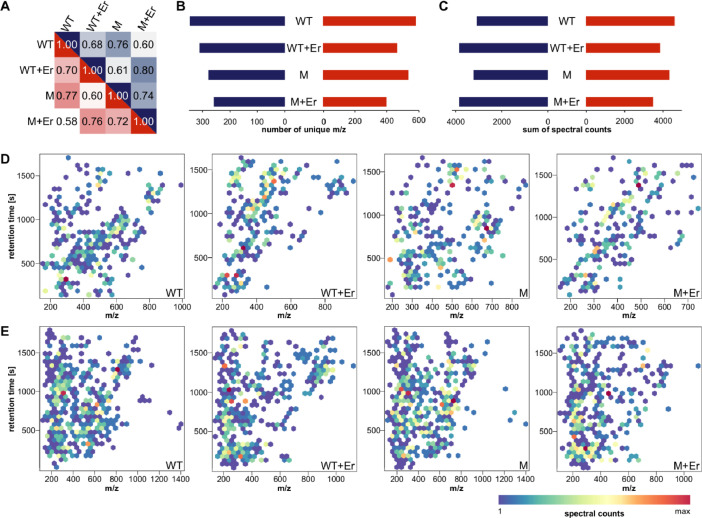
Comparison of mass spectrometric profiles. ASimilarity of secreted metabolomes. Cosine similarity scoring based on all signals observed in liquid chromatography-coupled mass spectrometry. Colour code: positive mode – blue; negative mode – red.BChemical diversity based on the number of unique signals observed in mass spectrometry.CAmounts of compounds based on the sum of spectral counts observed in mass spectrometry.DSecreted metabolite profiles of positive mode data. Maximum counts: WT – 130; WT+Er – 127; M – 98; M+Er – 161.ESecreted metabolite profiles of negative mode data. Maximum counts: WT – 107; WT+Er – 99; M – 84; M+Er – 84.